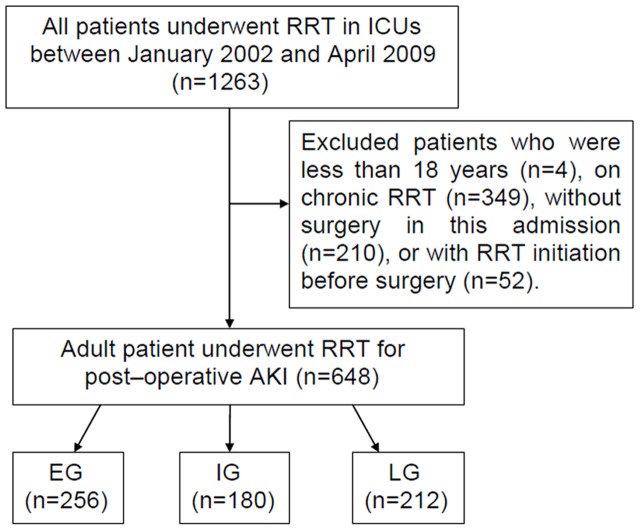
Approach to selecting and categorizing patients.EG, IG, and LG were defined as ≦ 1 day, 2–3 days, and ≧ 4 days between ICU admission and RRT initiation, respectively. Abbreviations: AKI, acute kidney injury; EG, early group; ICU, intensive care unit; IG, intermediate group; LG, late group; RRT, renal replacement therapy.